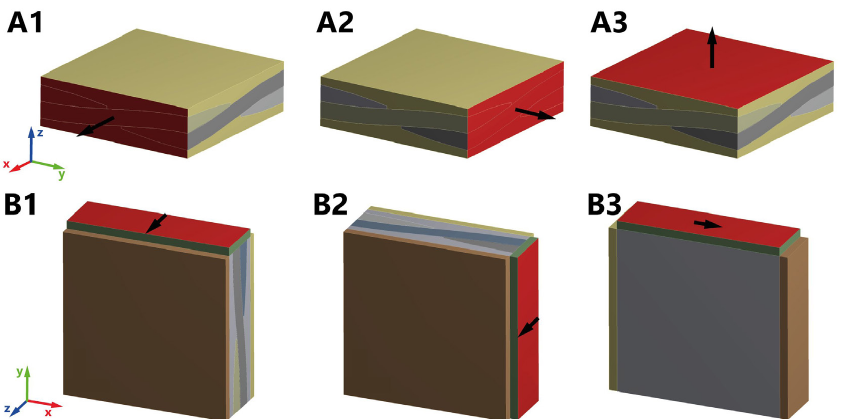
Figure 4. Six cases used in the homogenization process carried out on the RVE. Cases A1-3 represent the tension tests in three axes: x, y and z. Cases B1-3 represent the shear tests in three planes: xy, yz and xz. Shear test models include additional non-deformable elements to ensure pure strain